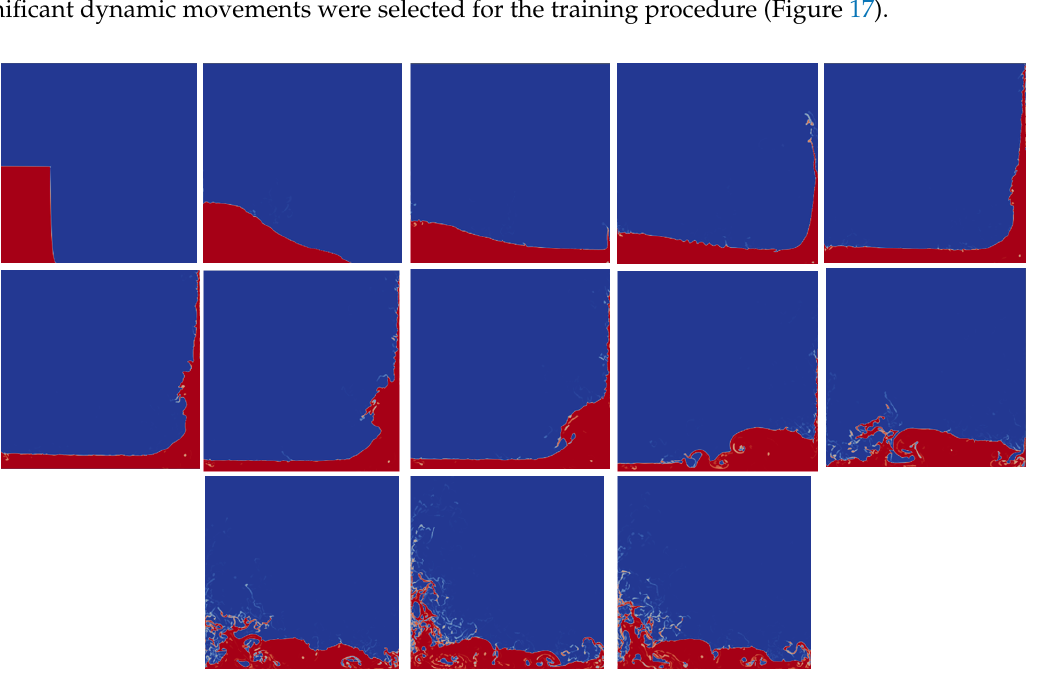
Figure 17. Significant dynamics selected for the training process.